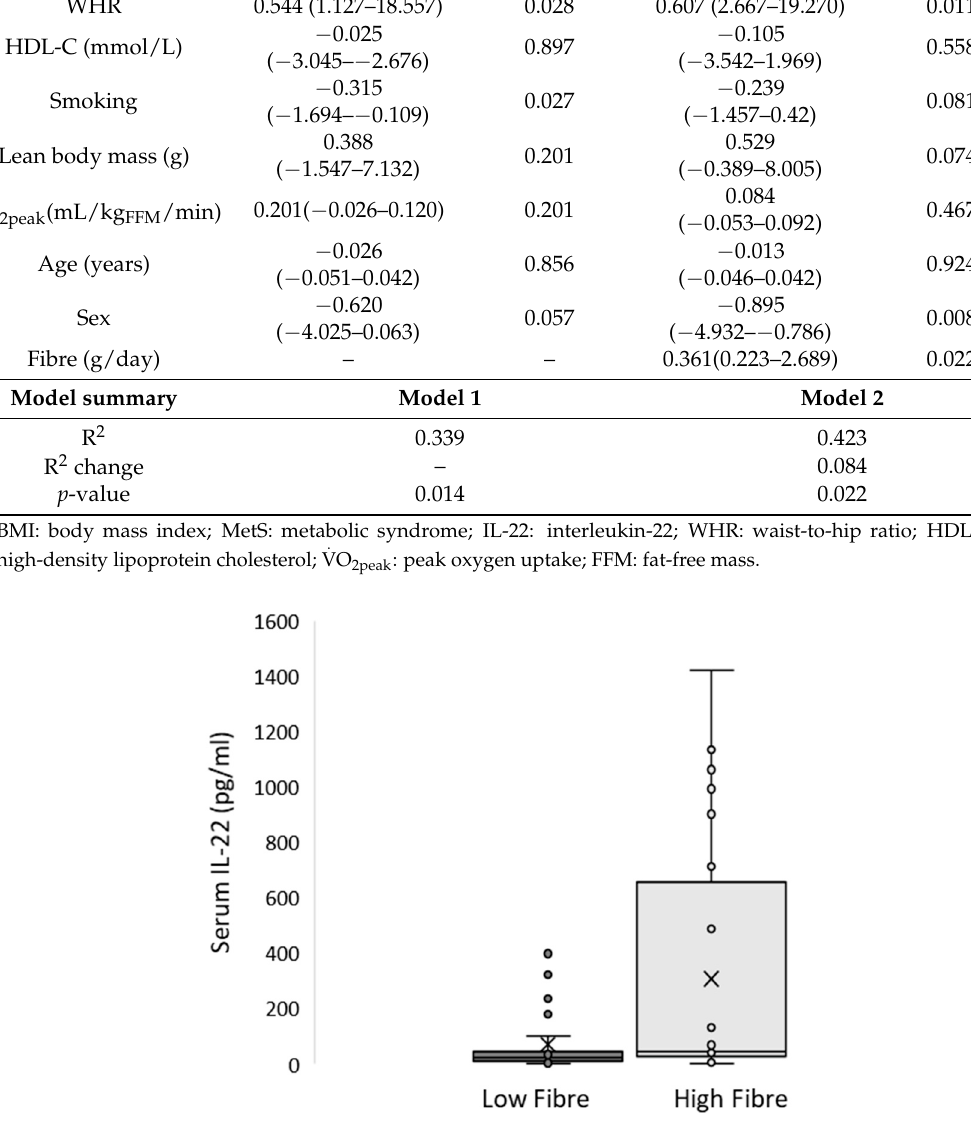
Figure 1. Circulating IL-22 concentration by fibre intake groups. The high-fibre intake group (above median intake of 21.5 g/day) had a significantly higher circulating IL-22 than the low-fibre intake group (mean 308.3 ± 454.4 vs. 69.0 ± 106.4 pg/mL, respectively p < 0.019). Table 3. Hierarchical multiple regression coefficients for the variables included in each model (circulating IL-22 levels as the dependent variable).